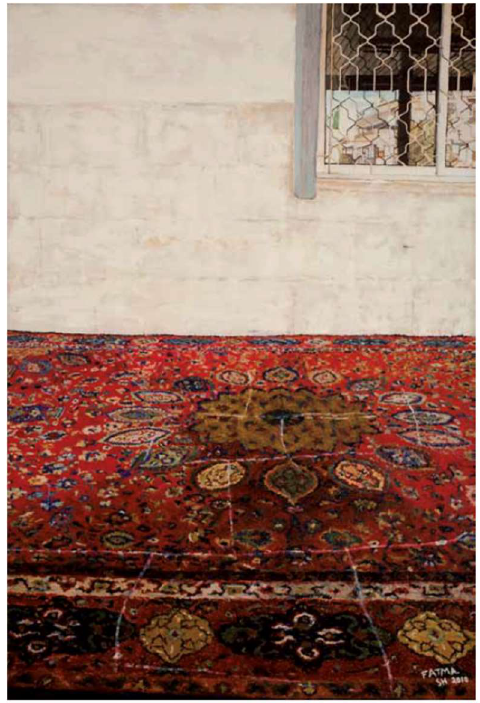
Figure 14. Fatma Shanan, A Carpet and A Window , 2010, oil on canvas, 150 × 100, private collection, Givat Ella.